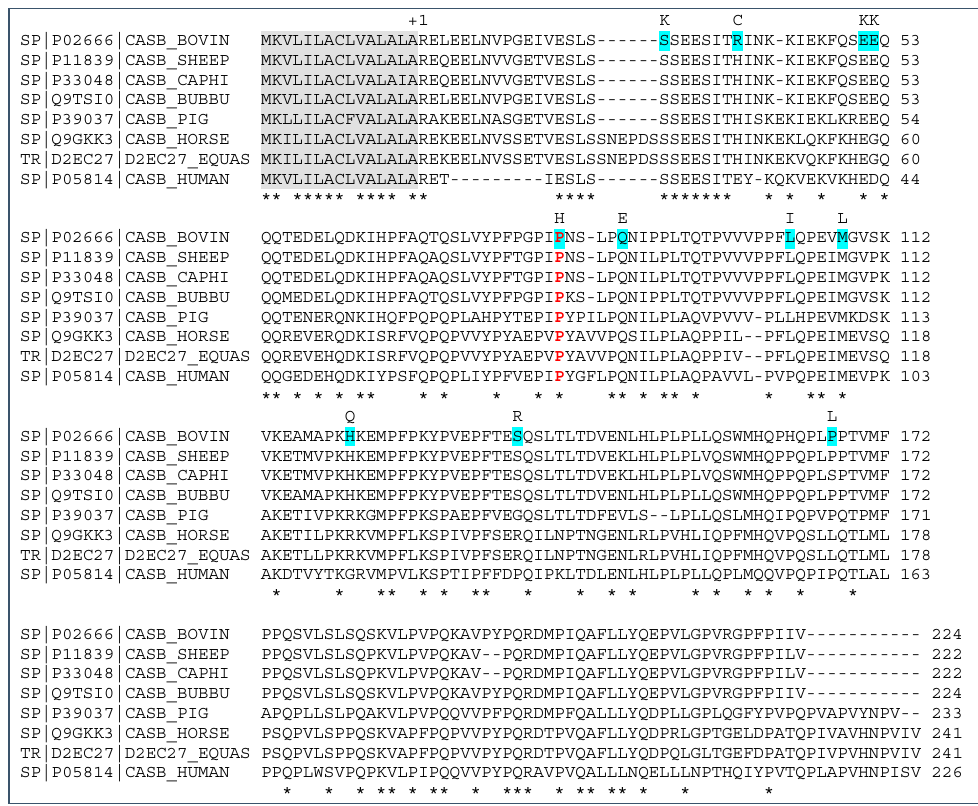
Figure 1. Multiple alignment of β -CN pre-protein in different species, in the following order: cattle, sheep, goat, buffalo, pig, horse, donkey, and human. P02666 sequence corresponds to the bovine A 2 variant. Outlined in grey: signal peptide; in light blue: natural variations in cattle (the substituted amino acid is written above); in red: the amino acid corresponding to Pro 67 within the bovine mature protein sequence. +1: start of the mature protein. Symbol *: no amino acid substitution.